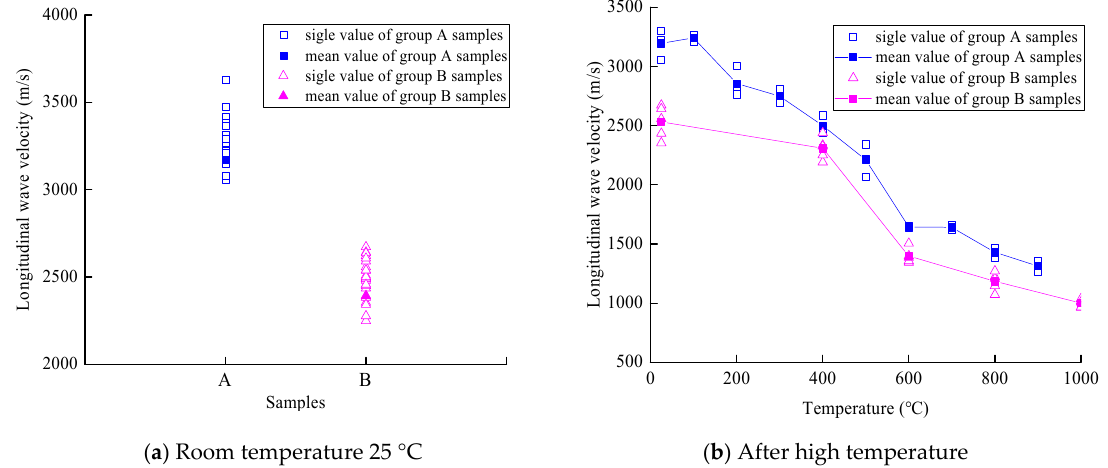
Figure 5. Longitudinal wave velocity of two sets of specimens at room temperature 25 °C and after high temperature.